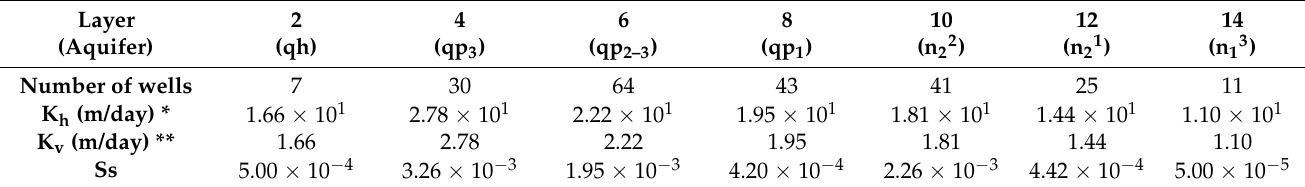
Table 1. Statistical average hydrogeology parameters of the